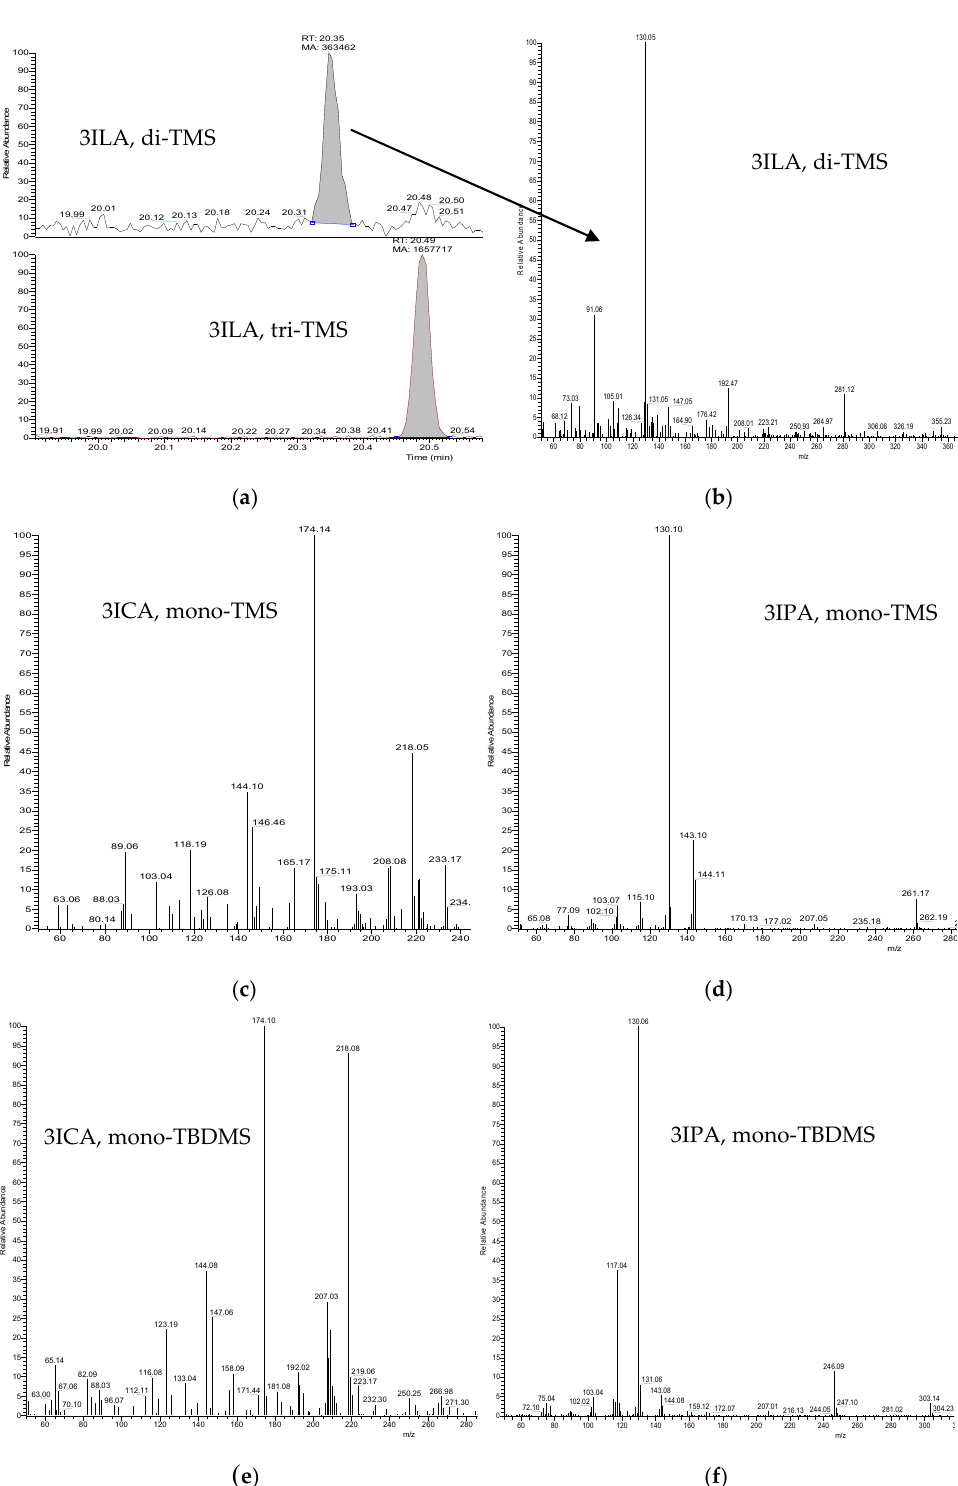
Figure 1. Fragments of mass chromatograms obtained using m / z values (Table 1) of di- and tri- trimethylsilyl (TMS) derivatives of indole-3-lactic acid (3ILA) ( a ), the mass spectra of the di-TMS derivative of 3ILA ( b ), the mono-TMS derivatives of indole-3-carboxylic acid (3ICA) ( c ) and indole-3-propionic acid (3IPA) ( d ), and the mono- tert -butyldimethylsilyl (TBDMS) derivatives of 3ICA ( e ) and 3IPA ( f